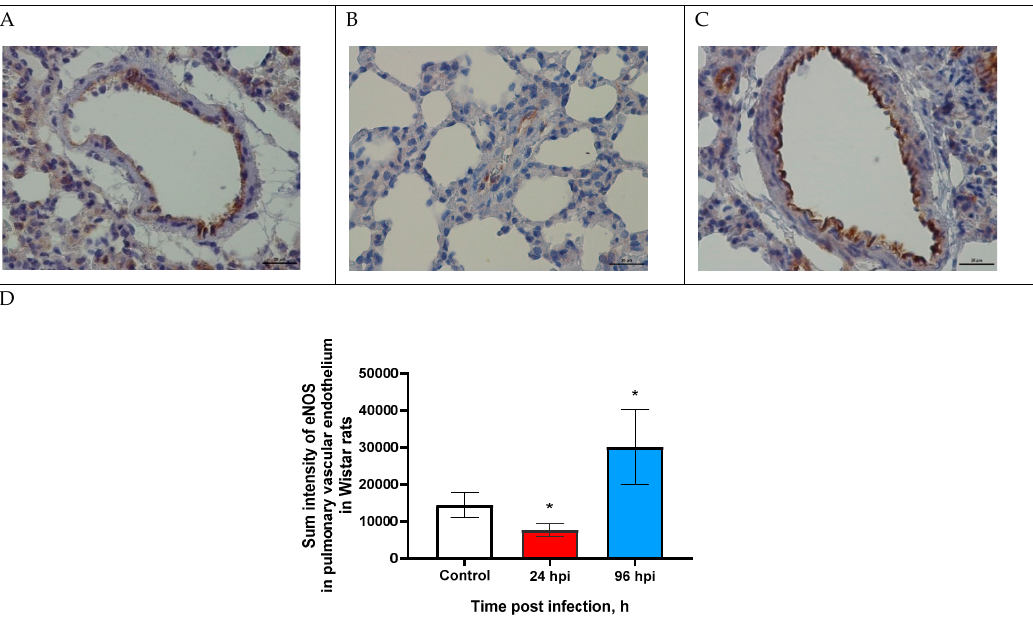
Figure 1. eNOS expression in pulmonary vascular endothelium of control rats ( A ) and infected at 24 ( B ) and 96 h post infection ( C ) with influenza A(H1N1)pdm09 virus using anti-eNOS murine mAbs. Magnification ×400; DAB chromogen staining. ( D ) eNOS sum intensity in pulmonary vascular endothelium of rats infected with influenza A(H1N1)pdm09 virus. Values represent mean ± standard deviation from 30 blood vessels of 10 rats in every group. * p < 0.05 versus control group (Kruskal–Wallis test). The expression of eNOS in the pulmonary vascular endothelium was evaluated by sum intensity parameter (Figure 1D). Thus, eNOS expression decreased by 1.9-fold (7643.7 ± 1802.3) at 24 hpi and increased by 2-fold (30,092.7 ± 10,042.9) at 96 hpi ( p < 0.05).